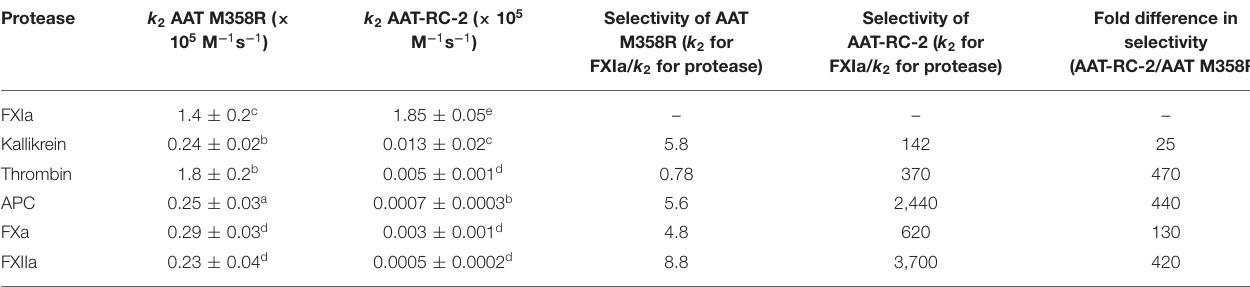
The mean of 3 a , 4 b , 5 c , 7 d , or 11 e determinations ± one standard deviation is shown, for kinetic parameters for AAT-RC-2 and AAT M358R with various